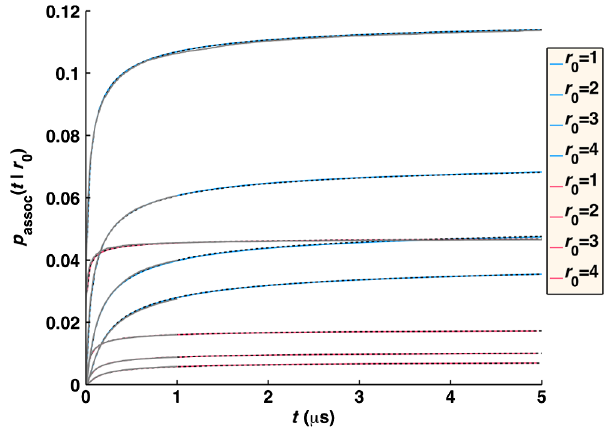
FIG. 7. Probability of two particles with an additional Coulomb interaction, β V ð r Þ ¼ r c =r , having associated between times 0 and t , given they were separated by a distance r 0 at t ¼ 0 . Blue lines are for an attractive interaction with r c ¼ − 1 , and pink lines are for a repulsive interaction with r c ¼ þ 1 . The binding radius is σ ¼ 1 nm, D AB ¼ 50 nm 2 = μ s, k a ¼ 50 nm 3 = μ s, and Δ t ¼ 0 . 01 μ s. The black dashed lines represent simulations propagated using the “ exact ” numerically solved GF to update the particle separations. The extremely close agreement between the re- weighted probabilities and the exact GF updates demonstrates that trajectory overlap is not an issue for this time step. These simulations are averaged over 10 7 trajectories, each initialized to the prescribed r 0 . The gray lines represent the association probability calculated using the BD scheme of Zhou [31]. These BD simulations are much slower than the FPR simulations due to the very short time step necessary, and for r 0 > 1 are propagated out to only t ¼ 1 μ s for 3 × 10 5 trajectories. For r 0 ¼ 1 , we collected 10 5 trajectories out to 10 μ